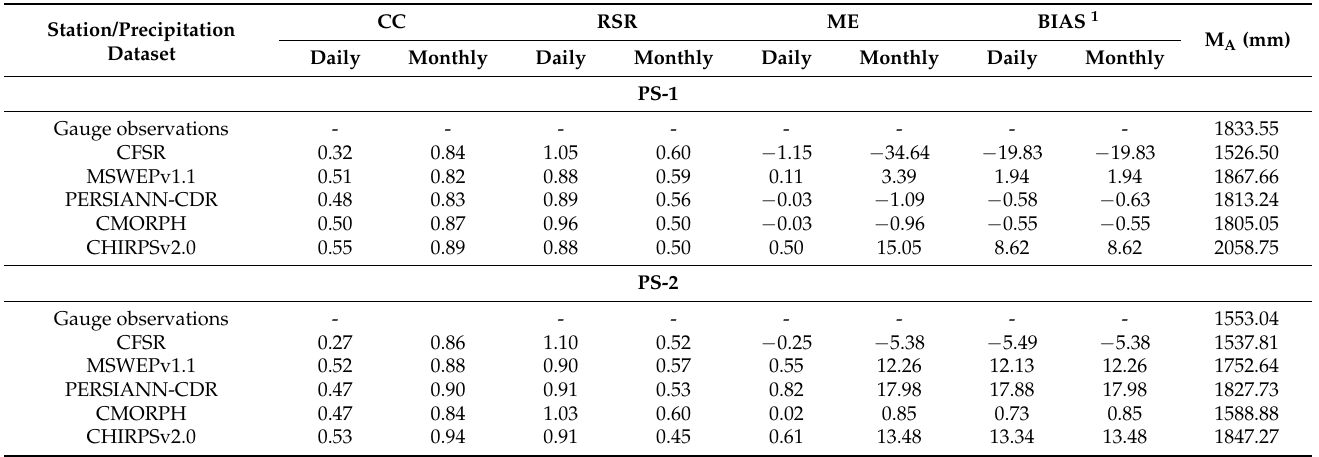
Table 8. Daily and monthly statistical indices of precipitation products against gauge observation at stations PS-1 and PS-2. Station/Precipitation